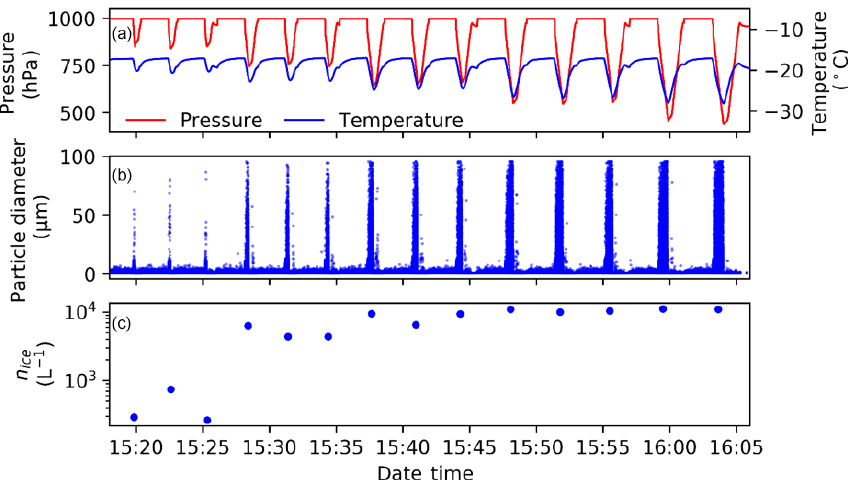
Figure 8. Repeated runs of PINE-1A sampling ATD aerosol from the AIDA cloud chamber during the EXTRA18 campaign. The runs were started at the same temperature of about − 18 ◦ C (blue line), but the minimum expansion pressure (red line) and thus also the minimum gas temperature in the PINE cloud chamber were stepwise changed every third run (a) . Therefore, the number of ice crystals formed by immersion freezing also stepwise increased, as shown in the single-particle plot from the welas 2500 OPC data (b) and the ice crystal concentration measured at the end of each expansion (c) .